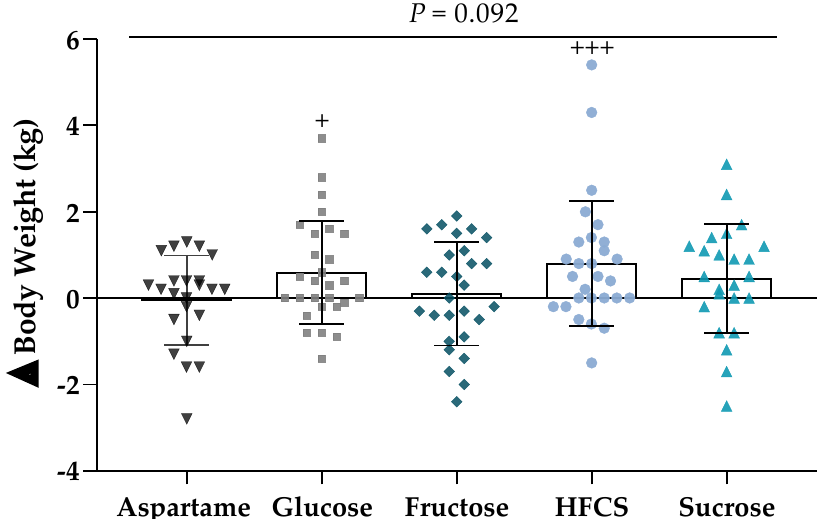
Figure 2. Body weight: The mean ± SEM of the absolute change (Week 2–Week 0) in body weight in subjects consuming either glucose-, fructose-, high fructose corn syrup (HFCS)-, sucrose-, or aspartame-sweetened beverages for 2 weeks. Two-factor (SB group, sex) analysis of covariance with adjustment for outcome at Week 0; + p < 0.05, +++ p < 0.001, least squares (LS) mean different from zero.